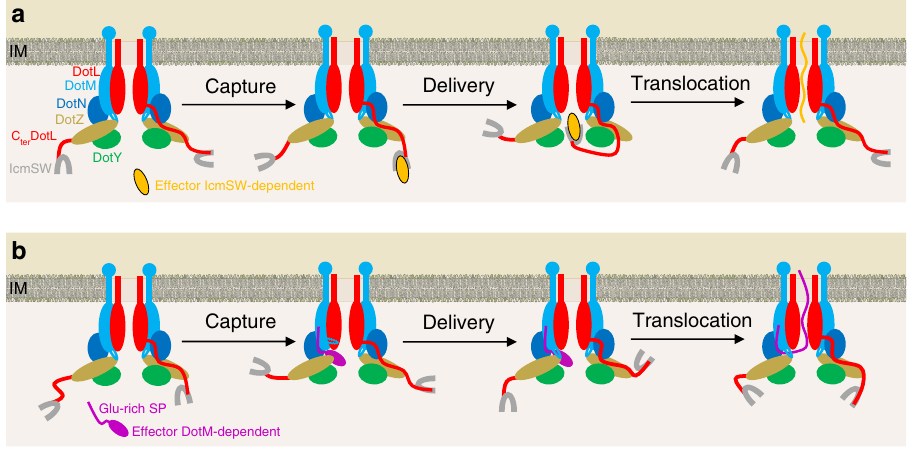
Fig. 6 Mechanistic models of substrate recruitment and delivery by the Legionella T4CC. a IcmSW-dependent effectors. Positional fl exibility of the IcmSW module relative to the rest of the structure provides a means to scan the immediate environment to maximise substrate capture (step 1) by the T4CC. Once bound, because of the motions trajectory, the effector will be delivered to the DotL channel (step 2 “ delivery ” ). Binding to IcmSW may induce IcmSW-dependent effectors to partially unfold 23 . However, structural details of effector-IcmSW interactions are not known. Additionally, DotL might be able to use its ATPase activity for the dual purpose of unfolding and transport (step 3 “ translocation ” ). LvgA is not shown because it is not present in the structure presented here. b Glu-rich SP-containing effectors. Glu-rich SP-containing effectors bind to a region of DotM that induces the SP to insert into a cavity formed by three of the T4CC proteins. For the full-length effector protein to bind there, there would be a requirement for the cavity to open up (step 1 “ capture ” ). To do so, we hypothesize that the β 1 β 2 loop of DotM might swing out, allowing the DotM-bound effector to slot in to position itself under the DotL channel (step 2 “ delivery ” ). How would then the effector in the DotL channel unfold remains unclear but it cannot be excluded that DotL might use its ATP-driven power to mediate unfolding (step 3 “ translocation ”